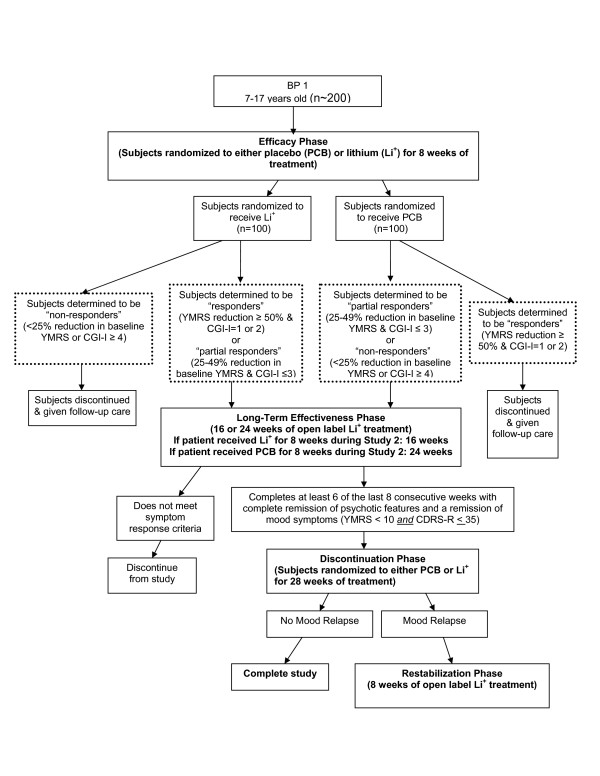
Study 2 of CoLT.